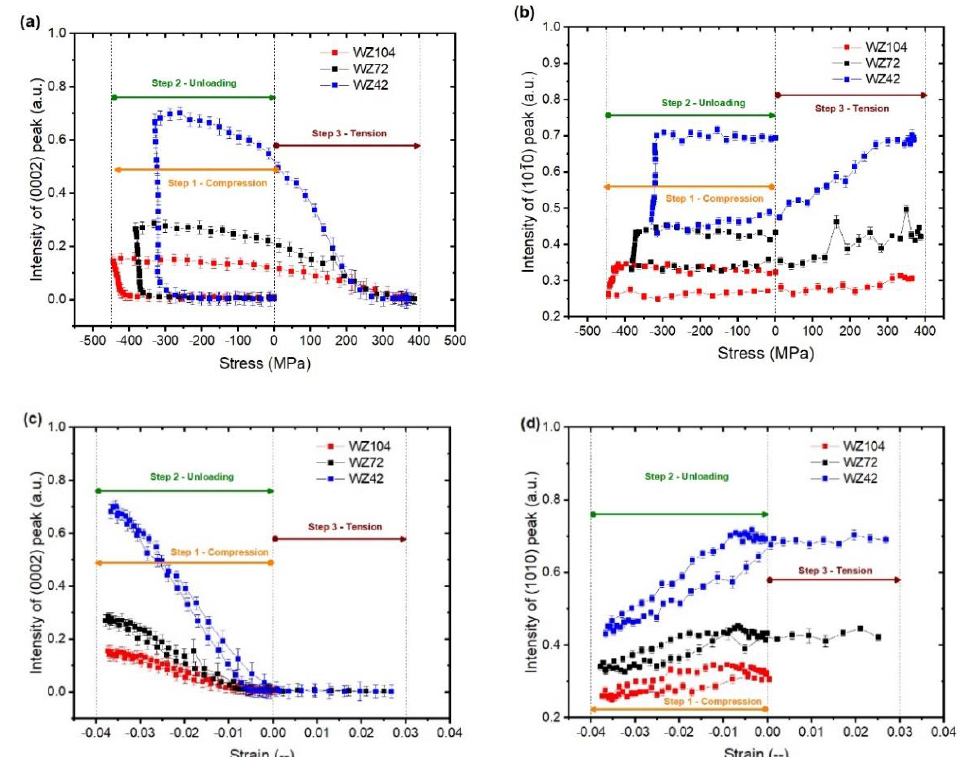
(cid:8) (cid:9) Figure 5. The intensity changes of the (0002)– 1010 peaks as a function of applied stress ( a , b ) and strain ( c , d ). Data from Figure 5. The intensity changes of the (0002)– {1010} peaks as a function of applied stress ( a , b ) axial and strain ( c , d ). Data from axial detector.